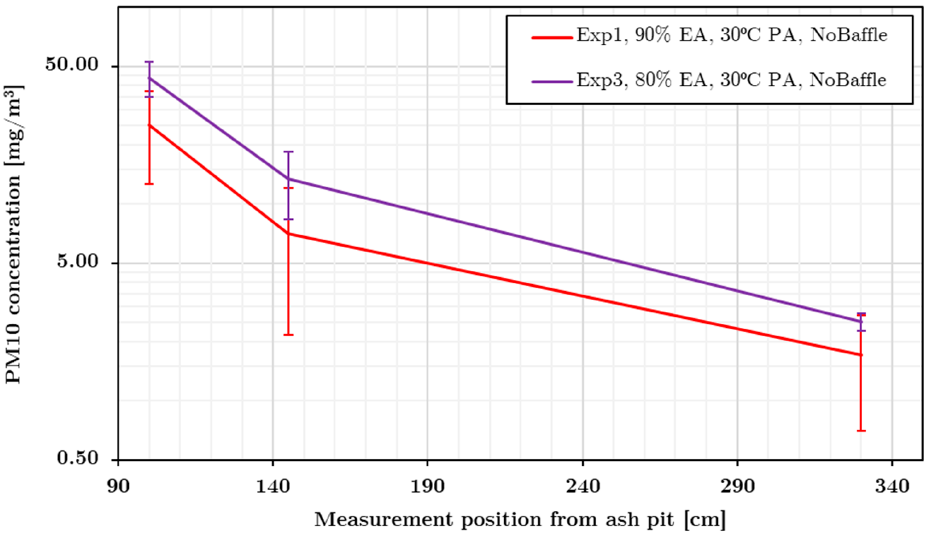
Figure 11. PM 10 measurement for different levels of excess air, and by utilization of secondary air injection (EA: excess air, PA: primary air).